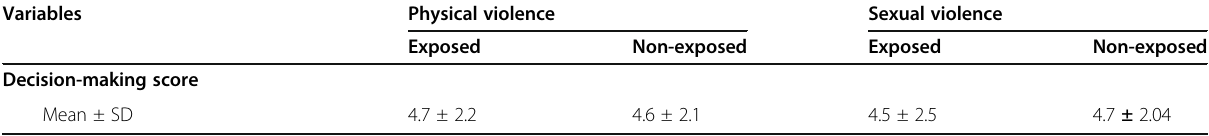
Table 3 Factors affecting exposure of married adolescent girls (MAGs) to physical and sexual violence, Upper Egypt (Continued) Variables